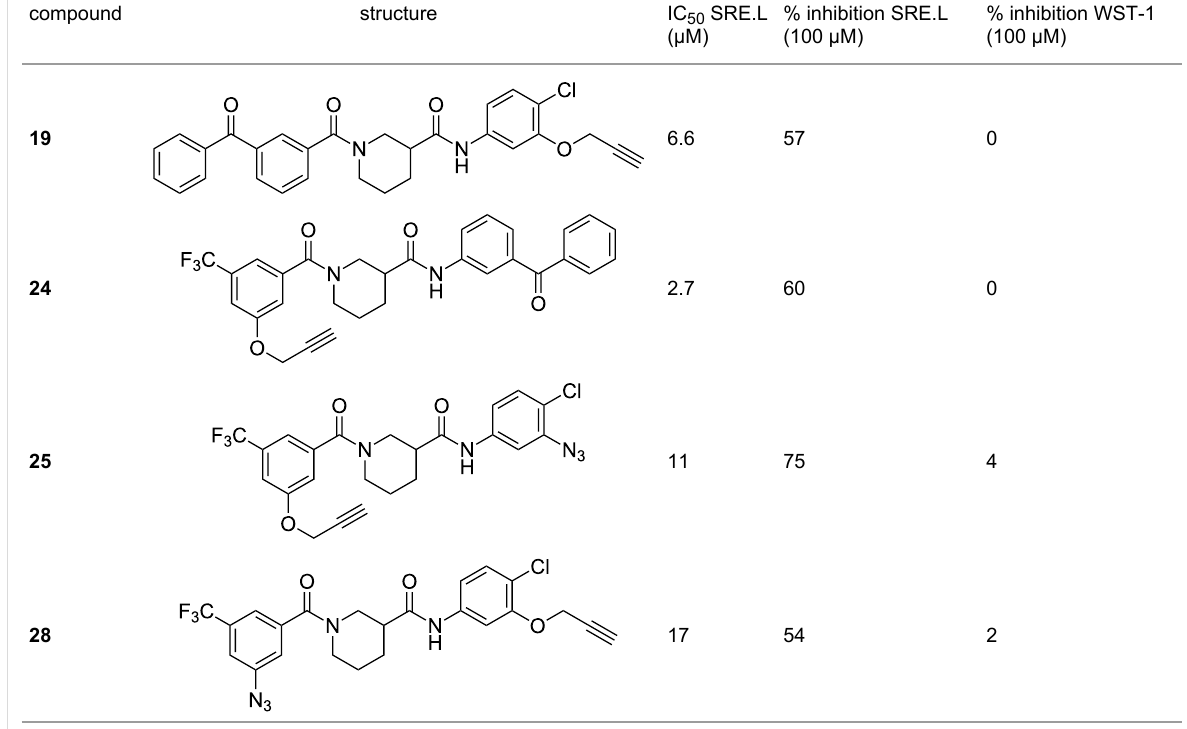
Table 2: Effects of tag-free photoprobes on transcription and cytotoxicity in PC-3 cells a .